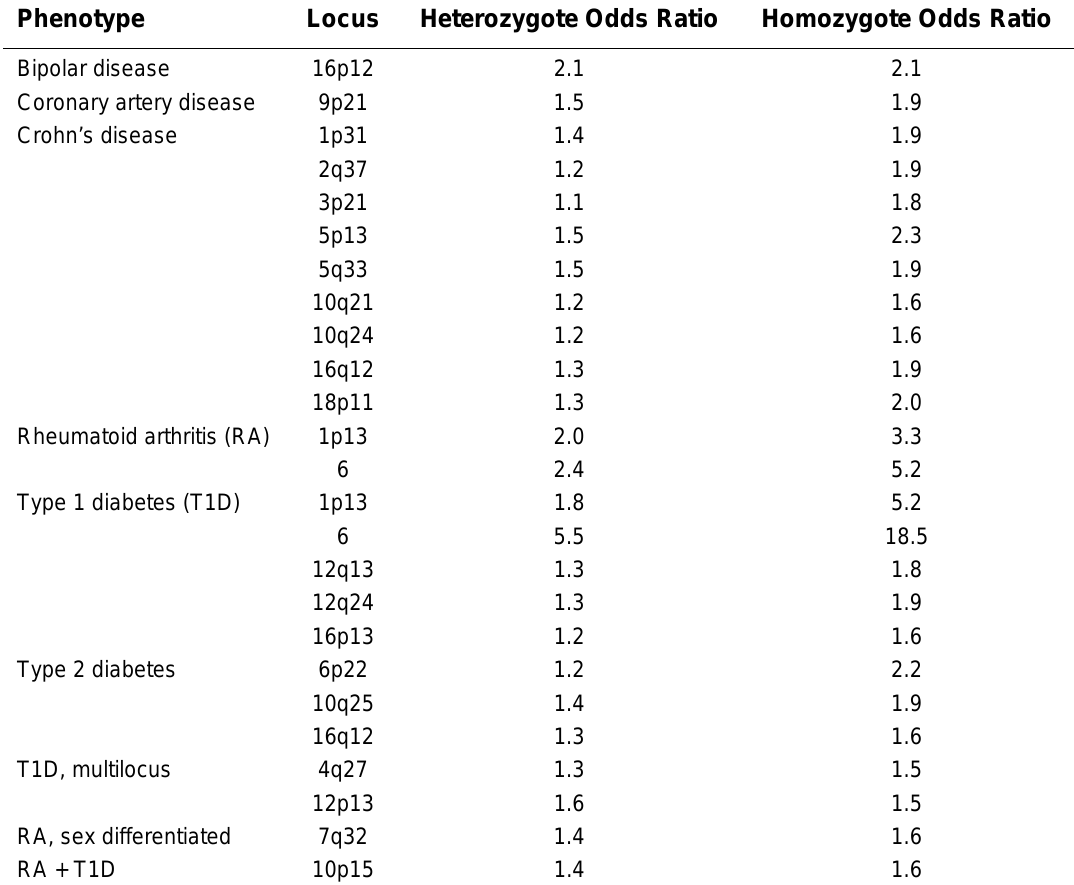
Effect Sizes of Loci for Seven Diseases Analyzed by WGA in the Wellcome Trust